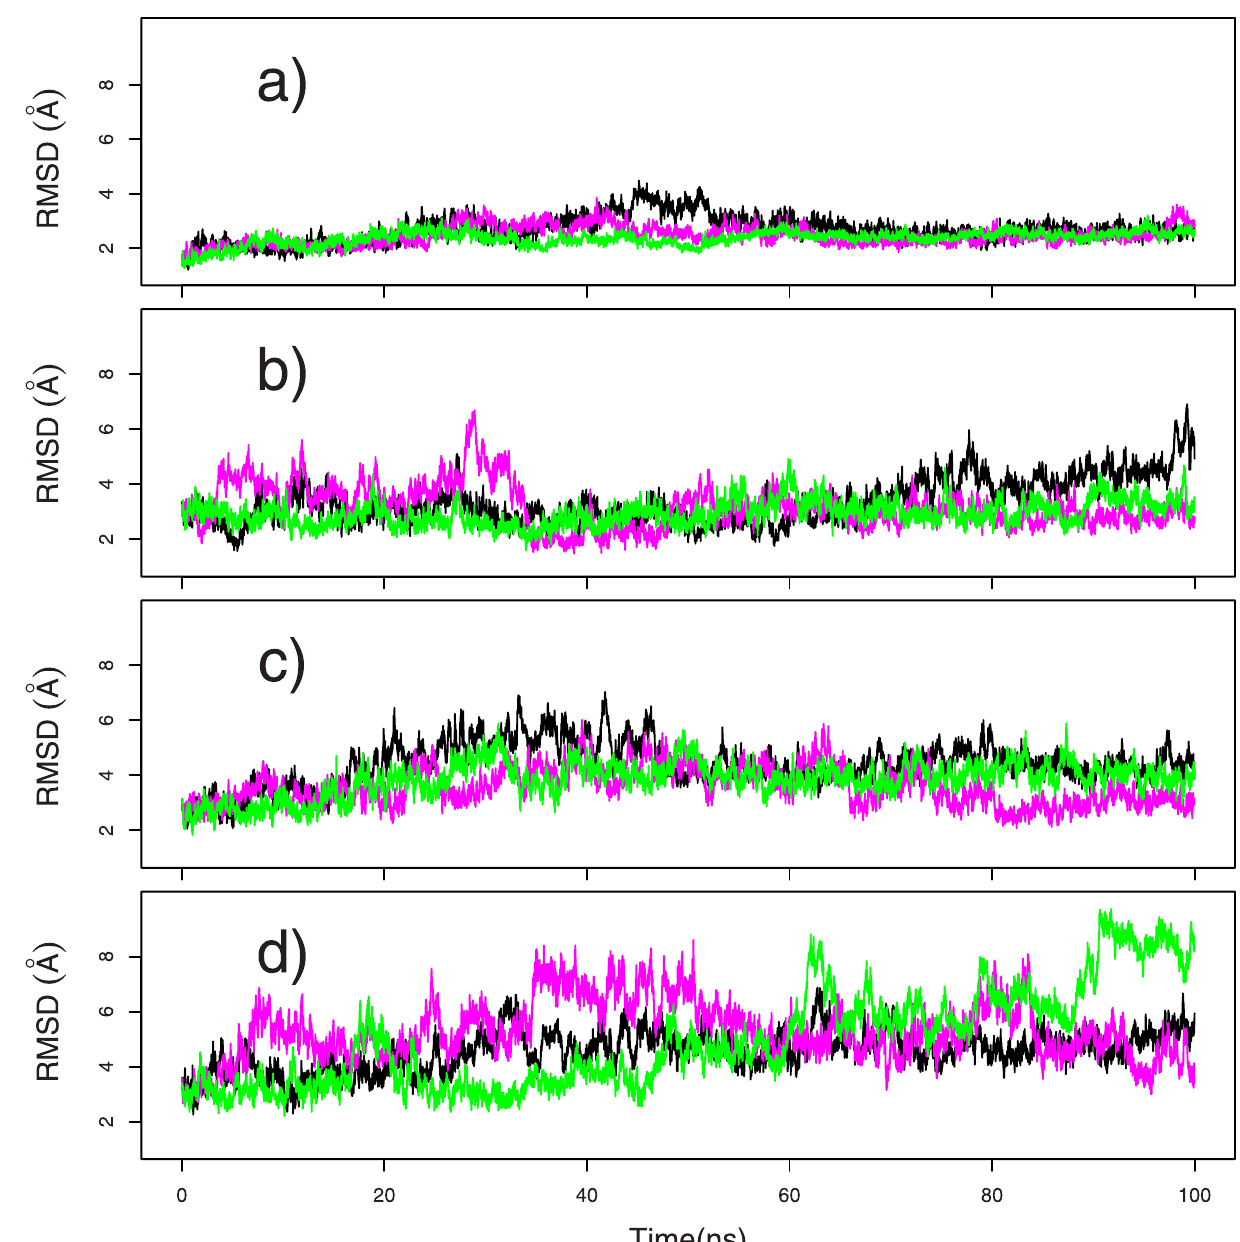
Fig 2. Coordinate root-mean-square deviations (RMSD, Å ) on the CpxA dimer. The coordinate RMSD are calculated on heavy atoms of the protein backbone with respect to the conformation of the PDB entry 4BIV. The deviations are calculated for the following three-times repeated trajectories: (a) MD, (b) dbl15, (c) mid15, (d) tet20. On each plots, the different curves correspond to different replicas and the same color/replica correspondance will be used in the